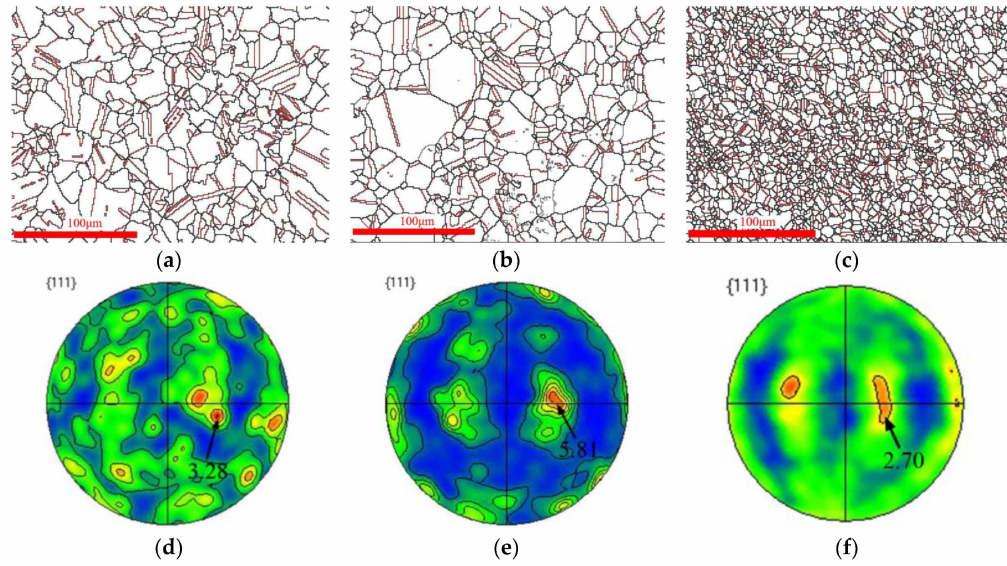
Figure 7. Microstructure and pole maps under different cold rolling reduction ( a )/( d ) ε = 0% ( b )/( e ) ε = 30% ( c )/( f ) ε =